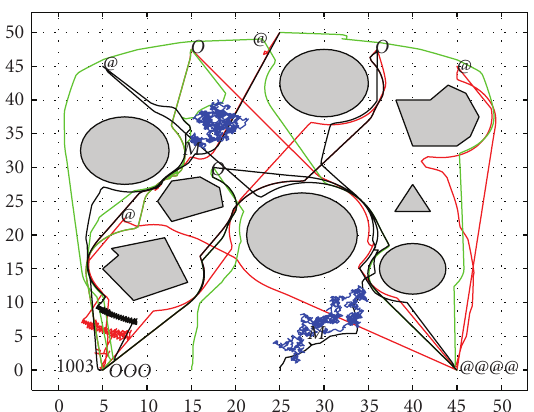
Figure 12: We show the simulation results with a more complex environment. Obstacles are larger and take on di ff erent shapes, and the workspace is more crowded. This figure is the snapshot after the task is completed. All three big objects are returned to the big object collection position and all four small objects are returned to the small object collection position.